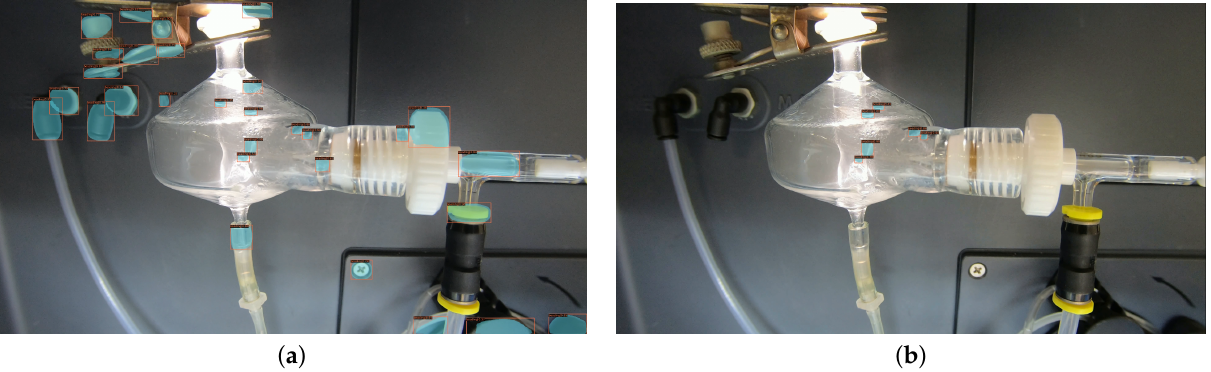
Figure 12. Inference on an un-cropped chamber, when model is trained without negative mining ( a ), and when trained with the OHEM sampler ( b ).